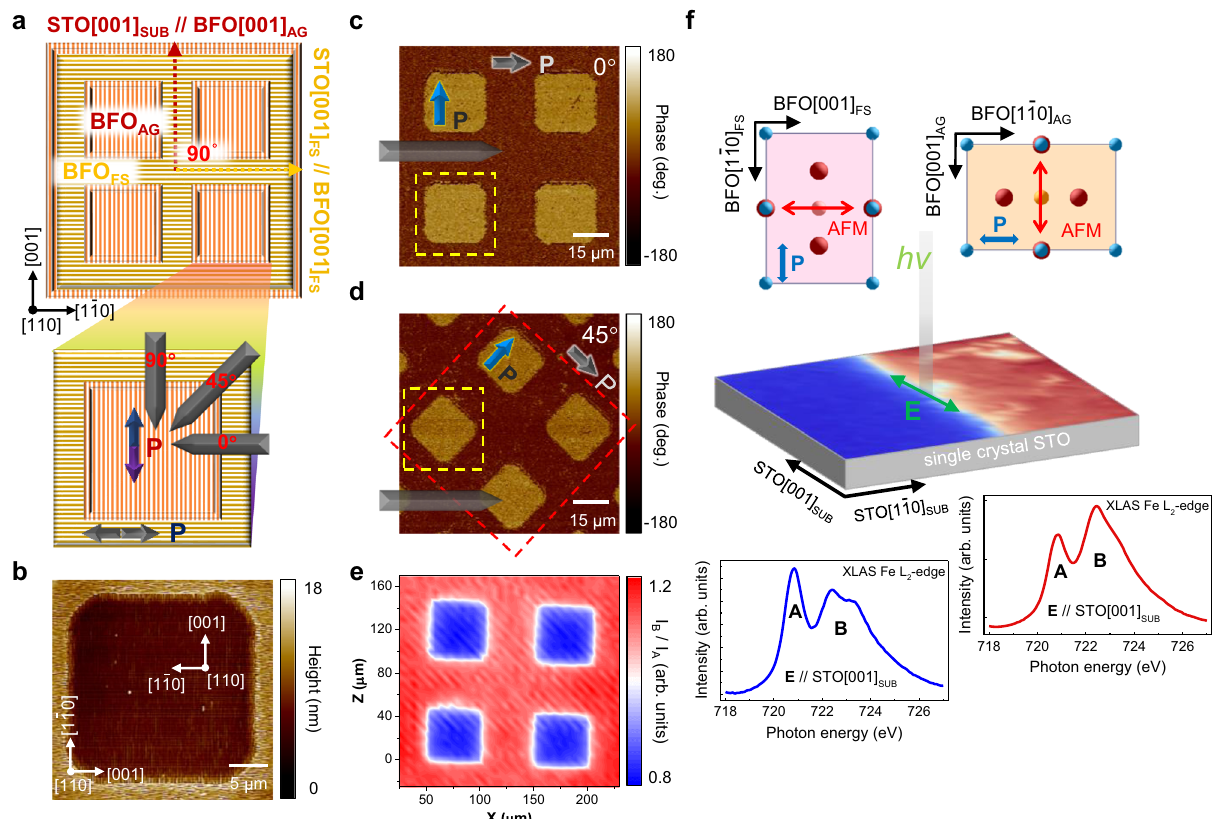
Fig. 3 Design of patterned lateral homostructures. a Schematic of the designer BFO (110) lateral homostructures, in which the stripes along BFO [001] direction are designed to be orthogonal. The enlarged area shows the direction of the AFM cantilever. b Topography image of the patterned lateral (110)- oriented BFO homostructures. The orthogonal stripes of BFO verify the feasibility of the designer patterns. c , d In-plane PFM phase images of the lateral BFO (110) homostructures with the probing cantilever parallel and 45 o to [001] direction of FS-STO. The net polarizations of BFO AG and BFO FS are shown in blue and gray arrows, respectively. e I B /I A ratio of XLAS mapping on the patterned lateral homostructures. f I B /I A ratio of XLAS mapping across the boundary of BFO AG and BFO FS area. The XLAS Fe L 2 -edge spectra taken from the as-grown BFO fi lm and the BFO fi lm on FS-STO are presented in blue and red colors, respectively (lower panels). The green arrow shows the electric polarization of the incident X-ray. The upper panels schematically show the correlation of the ferroelectric polarization and antiferromagnetic axes of the patterned